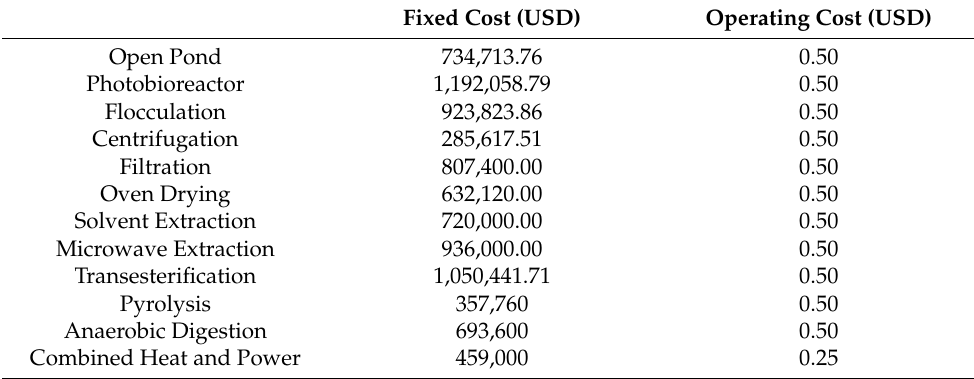
Table A3. Fixed and operating costs for each process unit [16,18,36].